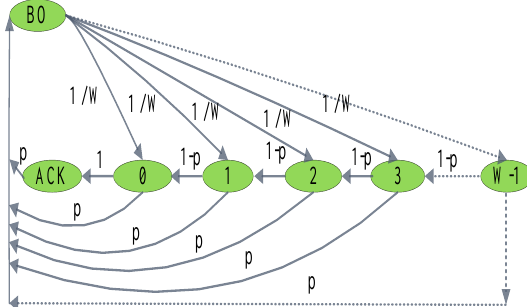
Figure 1. Discrete time Markov Chain of T-MAC Protocol.